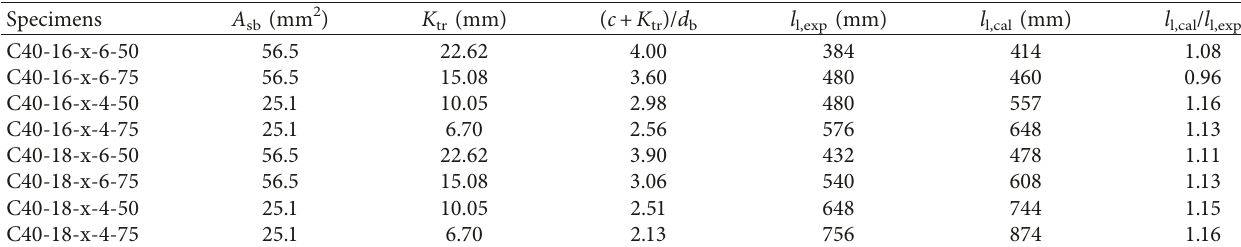
Figure 10: Fitted normal distribution of the reduction factor. Table 4: Comparison of lap